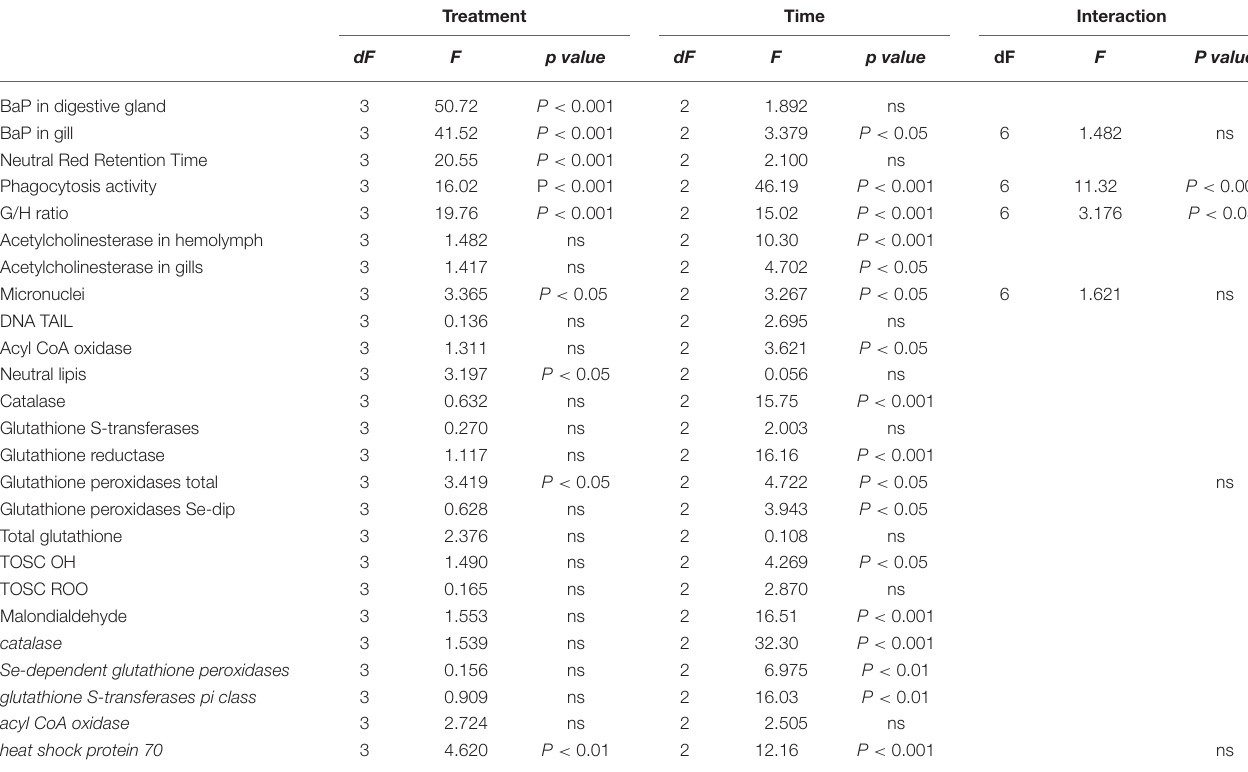
TABLE 2 | Results of two-way analysis of variance for the biological responses in mussels, M. galloprovincialis , exposed to different treatments (LDPE, BaP, and LDPE-BaP) for different times (7, 14, and 28